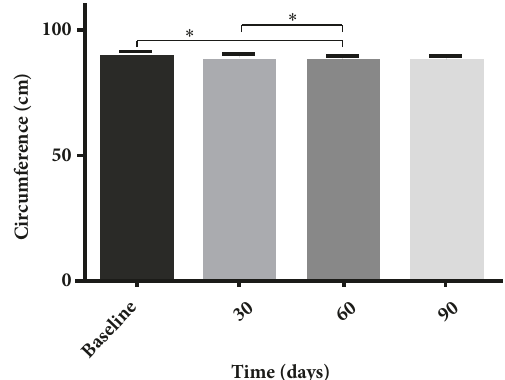
Figure 3: Means, with a standard error of the mean, of the waist circumference values before treatment (baseline) and after treatment (30, 60, and 90 days after treatment). ∗ P < 0.05).